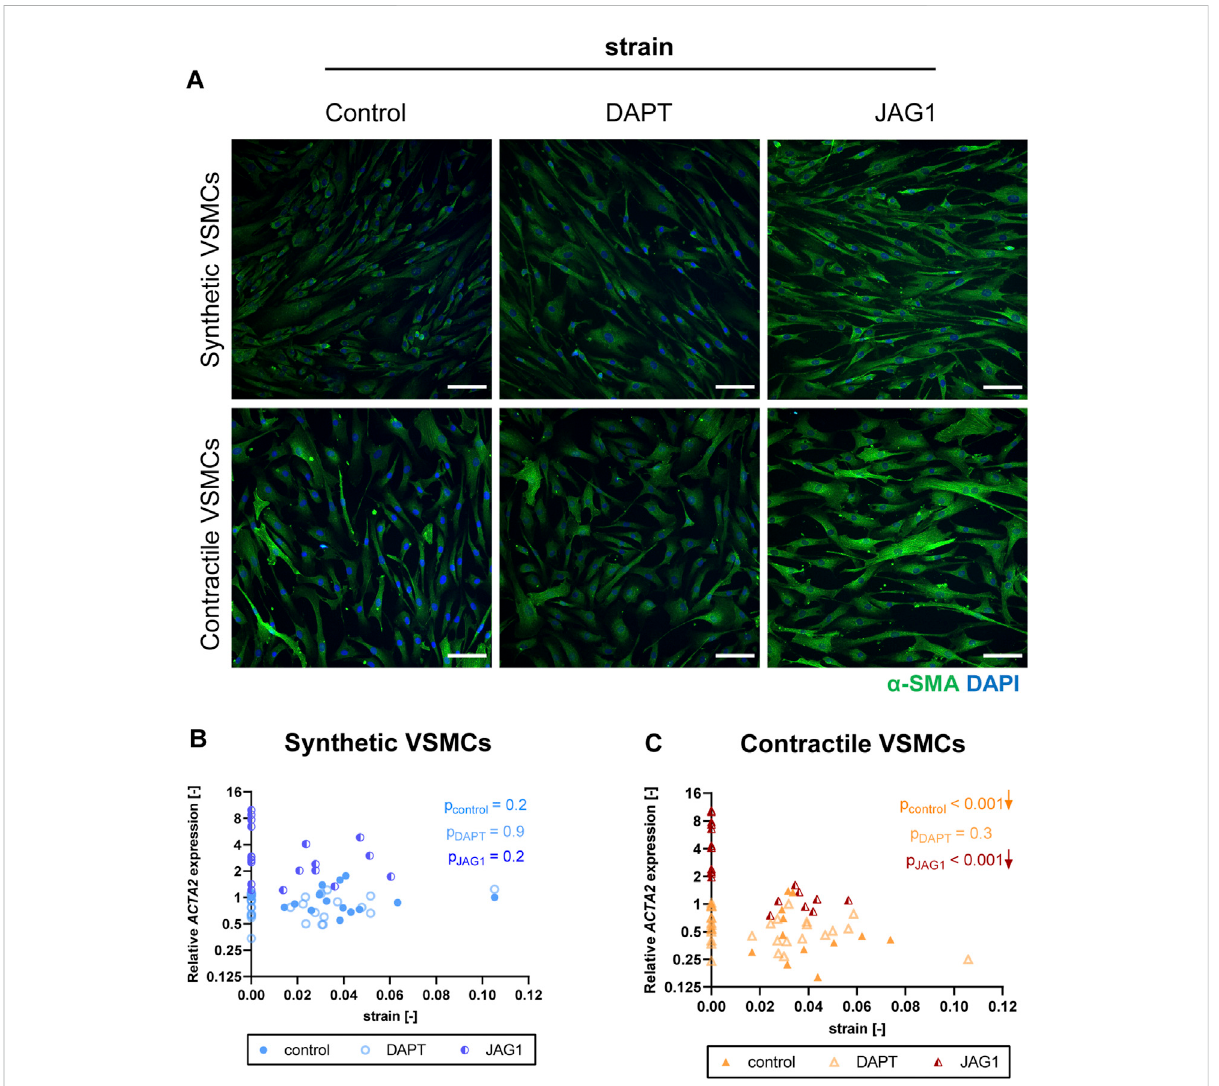
FIGURE 8 The impact of Notch signal inhibition and activation on strain-mediated changes in VSMC phenotype. (A) Representative IF images of α SMA (green) and nuclei (blue) for control, DAPT-treated and JAG1-induced synthetic and contractile VSMCs upon the application of 0.04 (4%) strain for 48 h (scale bar: 100 µm). Gene expression of phenotype marker ACTA2 for control, DAPT-treated and JAG1-induced (B) synthetic VSMCs (blue circles) and (C) contractile VSMCs (orange triangles) as a function of strain (normalized to static control expression). p values show